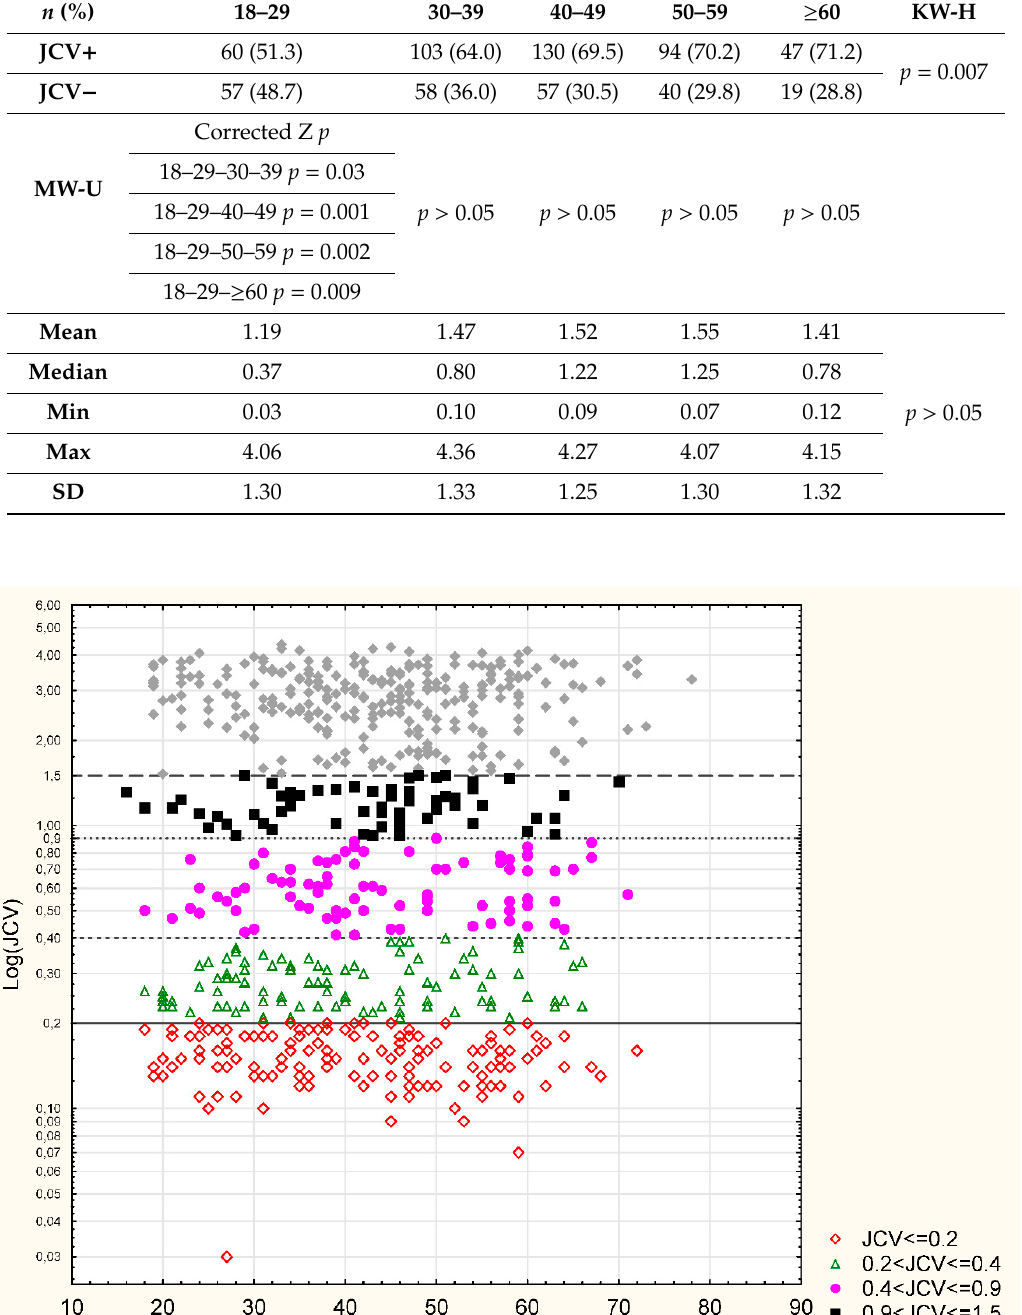
Table 5. Anti-JCV antibodies index categories and sex, clinical course, and EDSS score.